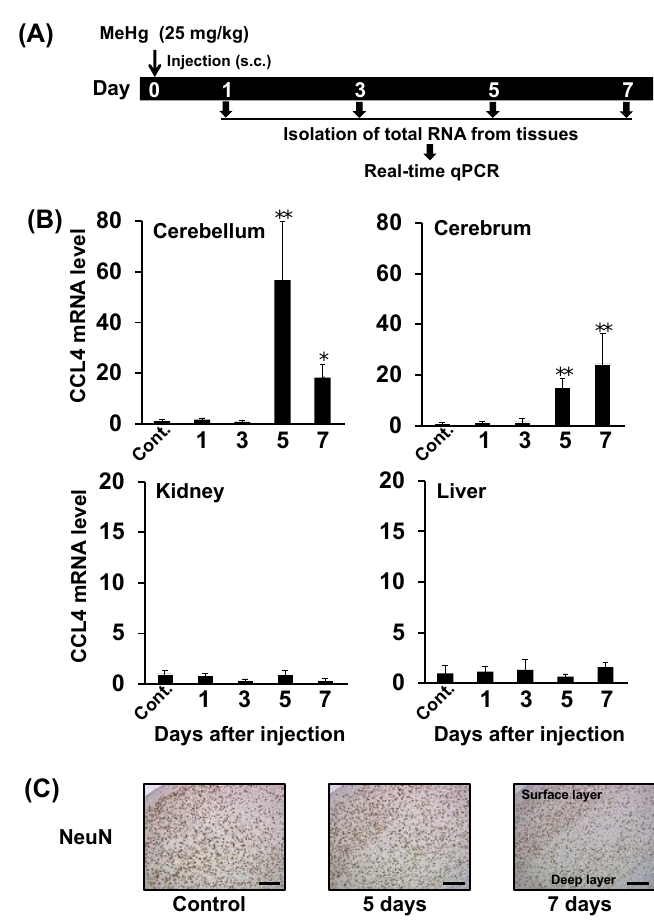
Figure 1. Relationship between neurological damage and CCL4 expression in the brains of mice treated with methylmercury. C57BL/6 mice were injected once subcutaneously with methylmercuric chloride (MeHg) (25 mg/kg). ( A ) Selected organs (cerebellum, cerebrum, liver and kidney) were dissected 1, 3, 5, or 7 days after the injection. Cont.: Control. ( B ) CCL4 mRNA levels in each organ were measured by quantitative real-time PCR. Data are represented as mean ± SD, * p < 0.05; ** p < 0.01 compared with “Control”. ( C ) NeuN (neuron marker)-positive cells in the cerebral cortex detected by immunostaining. Scale bars represent 250 µ m.